Question: From the figure, is the trend upward or downward?
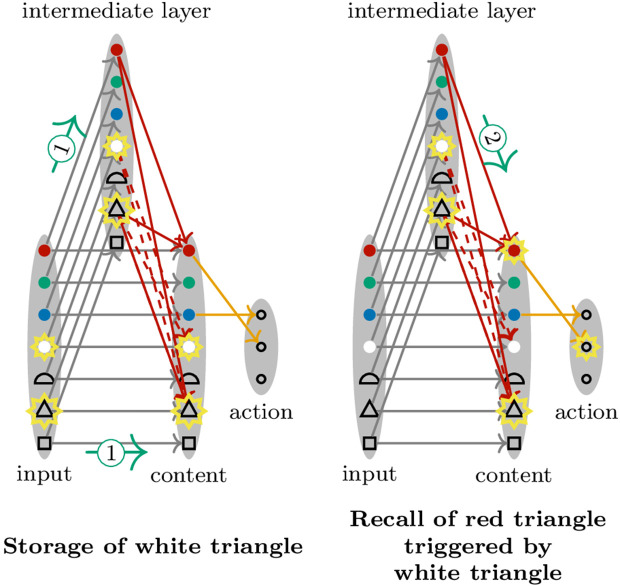
Answer: increasing